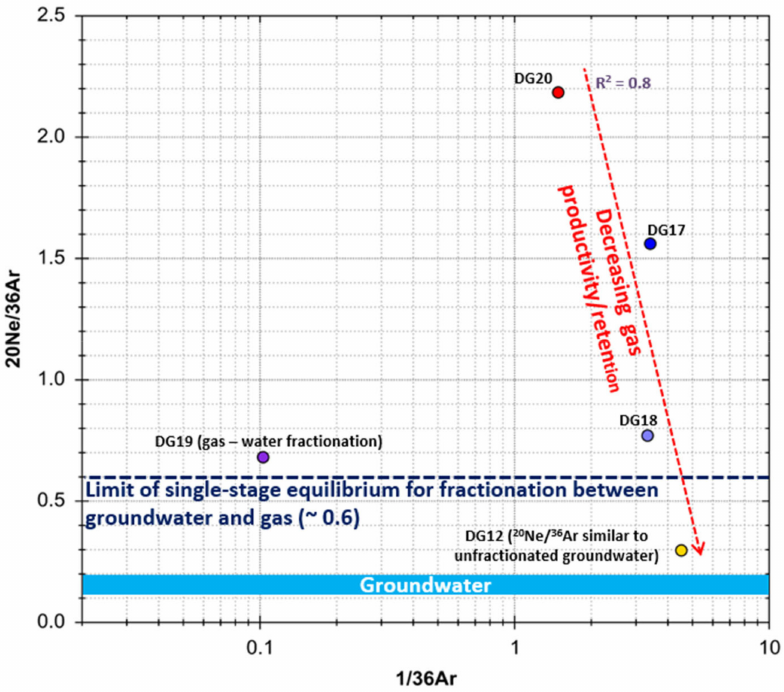
Figure 22. 20 Ne/ 36 Ar versus the reciprocal of 36 Ar concentration in five Marcellus dry gas samples. Mixing is evident between the two atmosphere-derived end members, one highly fractionated and the other non-fractionated. DG12 20 Ne/ 36 Ar is similar to unfractionated groundwater. DG19 and DG18 have elevated 20 Ne/ 36 Ar which plot near the upper limit for single-stage equilibrium for fractionation between groundwater and gas (~0.6) [44–47,51]. DG17 and DG 20 have unusually high 20 Ne/ 36 Ar [45,47]. Excepting DG19 sample, atmospheric 36 Ar exhibits a negative correlation with 20 Ne/ 36 Ar (R 2 = 0.8). Hunt and others [50] observed this negative correlation in other northern Appalachian natural gases, including Marcellus Formation gas. They noted that a negative cor- relation exists between ASW 36 Ar as 20 Ne/ 36 Ar approaches solubility, indicating the diffusion of Ne as fluids migrate. The DG19 gas is altered by mixing with secondary microbial CH 4 , and by apparent hydrolysis/corrosion. The high 36 Ar (9.65 µ cc/cc) likely reflects recent interaction with atmospheric